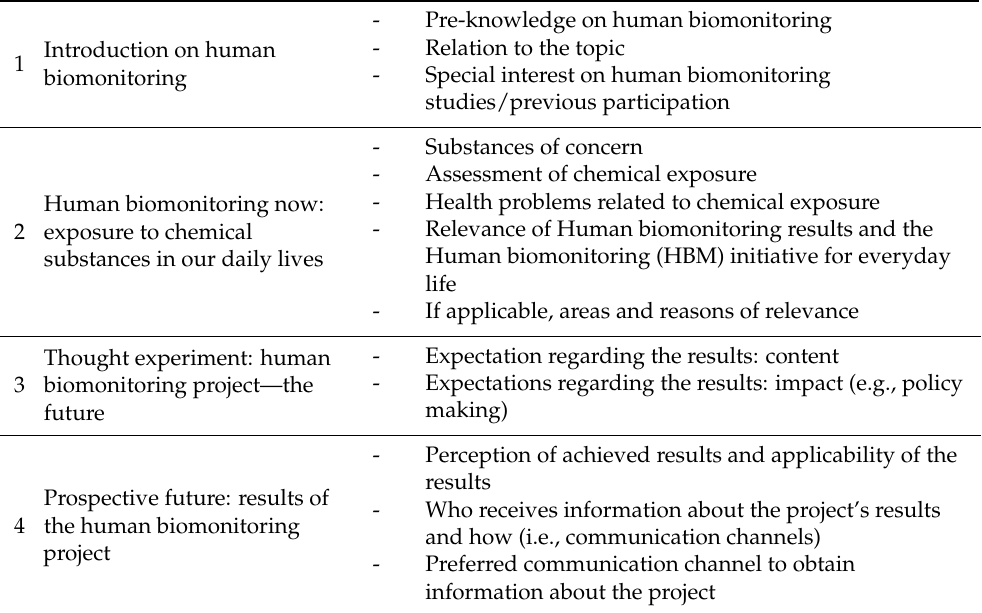
Table 1. Guidelines for conducting the focus group: relevant topics to be